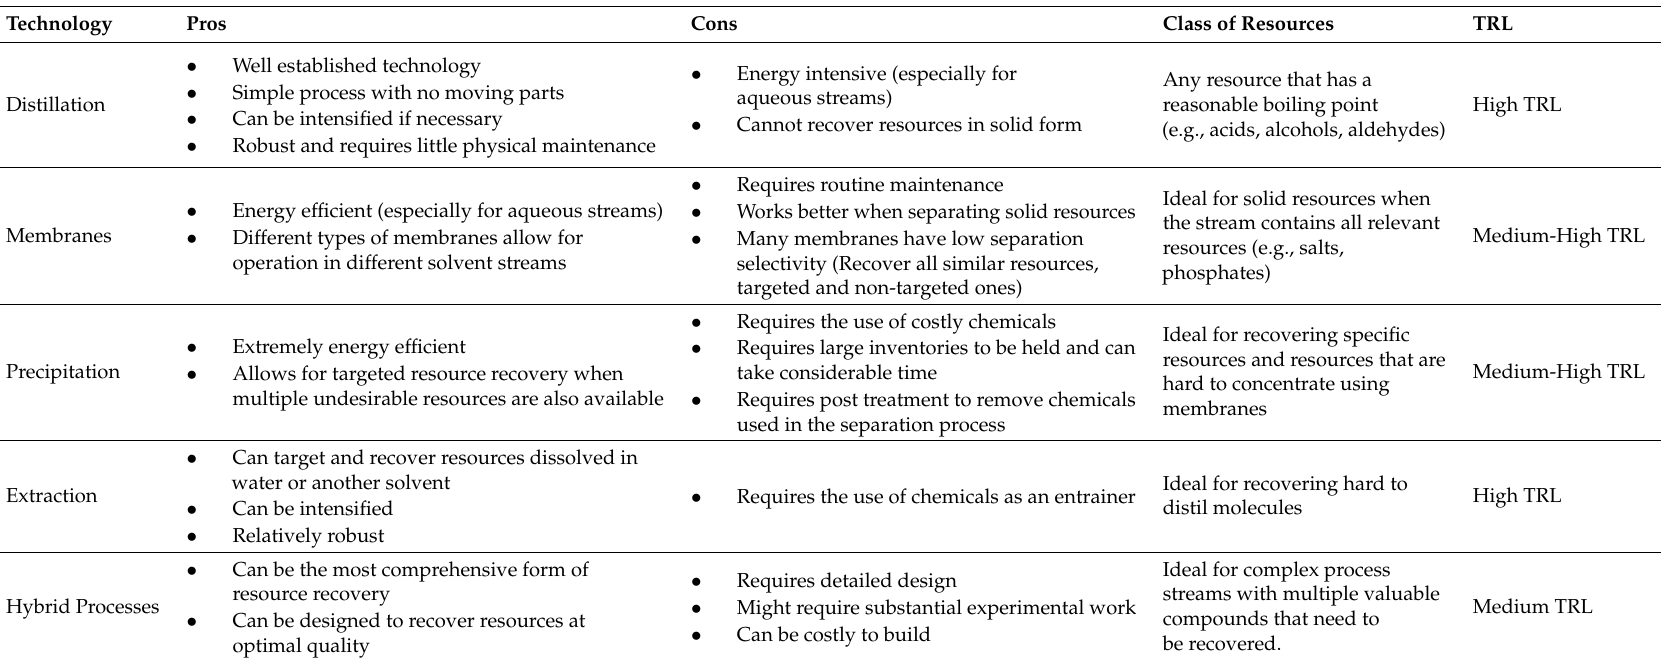
Table 4. Pros and cons of current separation technology applicable to resource recovery from bio-based waste